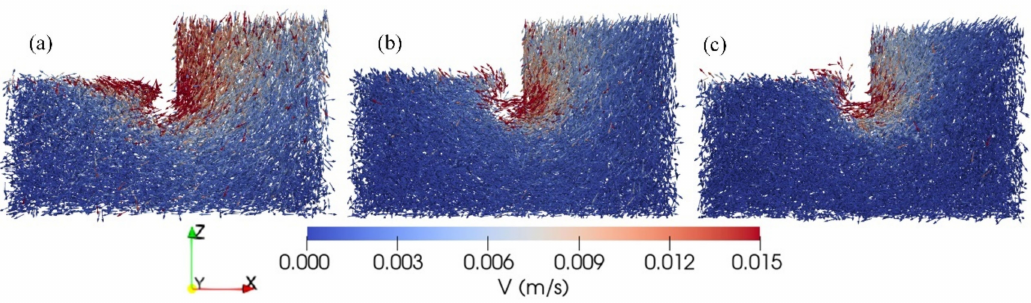
Figure 3. Evolution of water flow at t = ( a ) 0.01 s; ( b ) 0.1 s; and ( c ) 0.2 s.